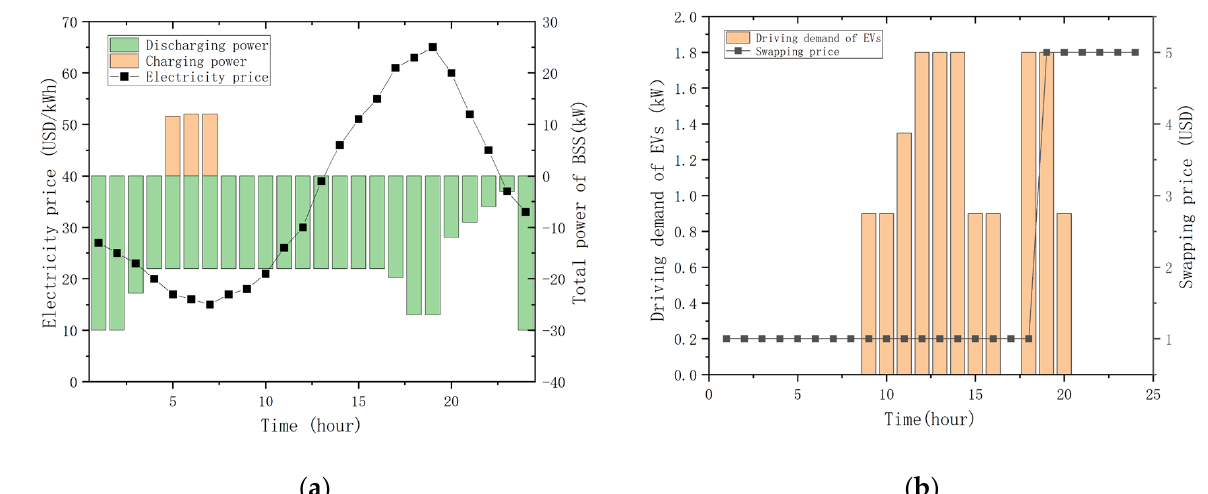
Figure 5. ( a ) Time-varying electricity price and charging/discharging power of BSS in Case 2; and ( b ) swapping price and driving demand of EVs in Case 2.